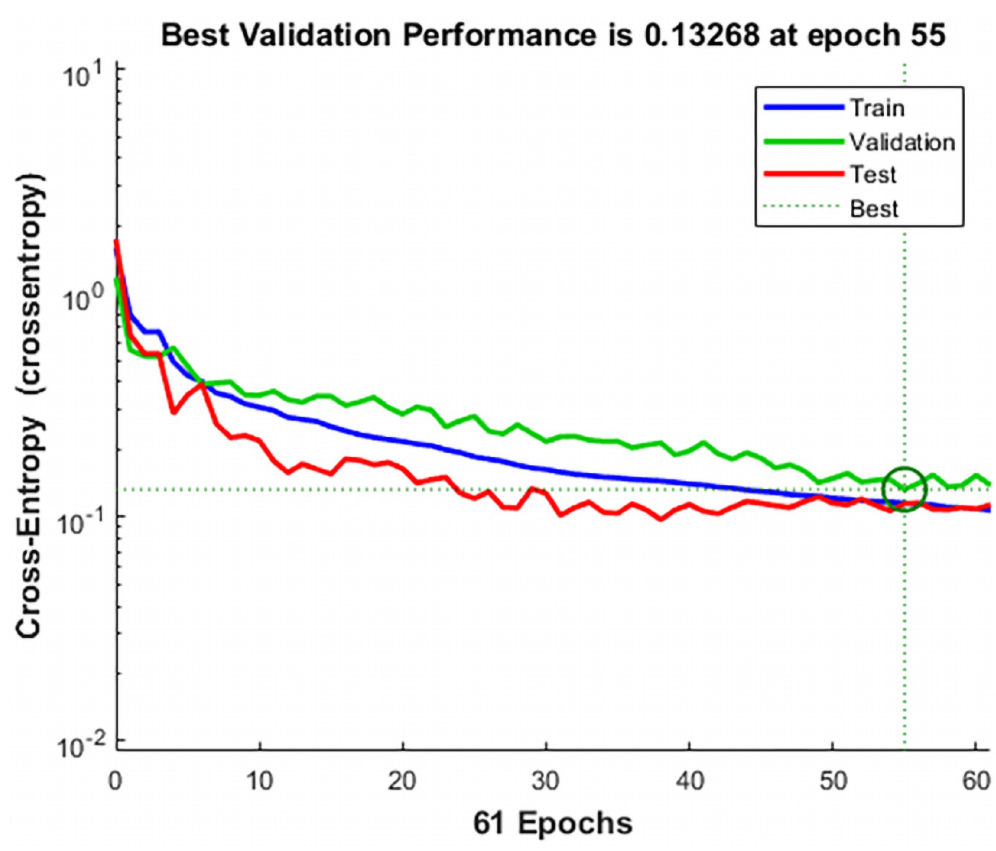
Fig 21. Loss function descent